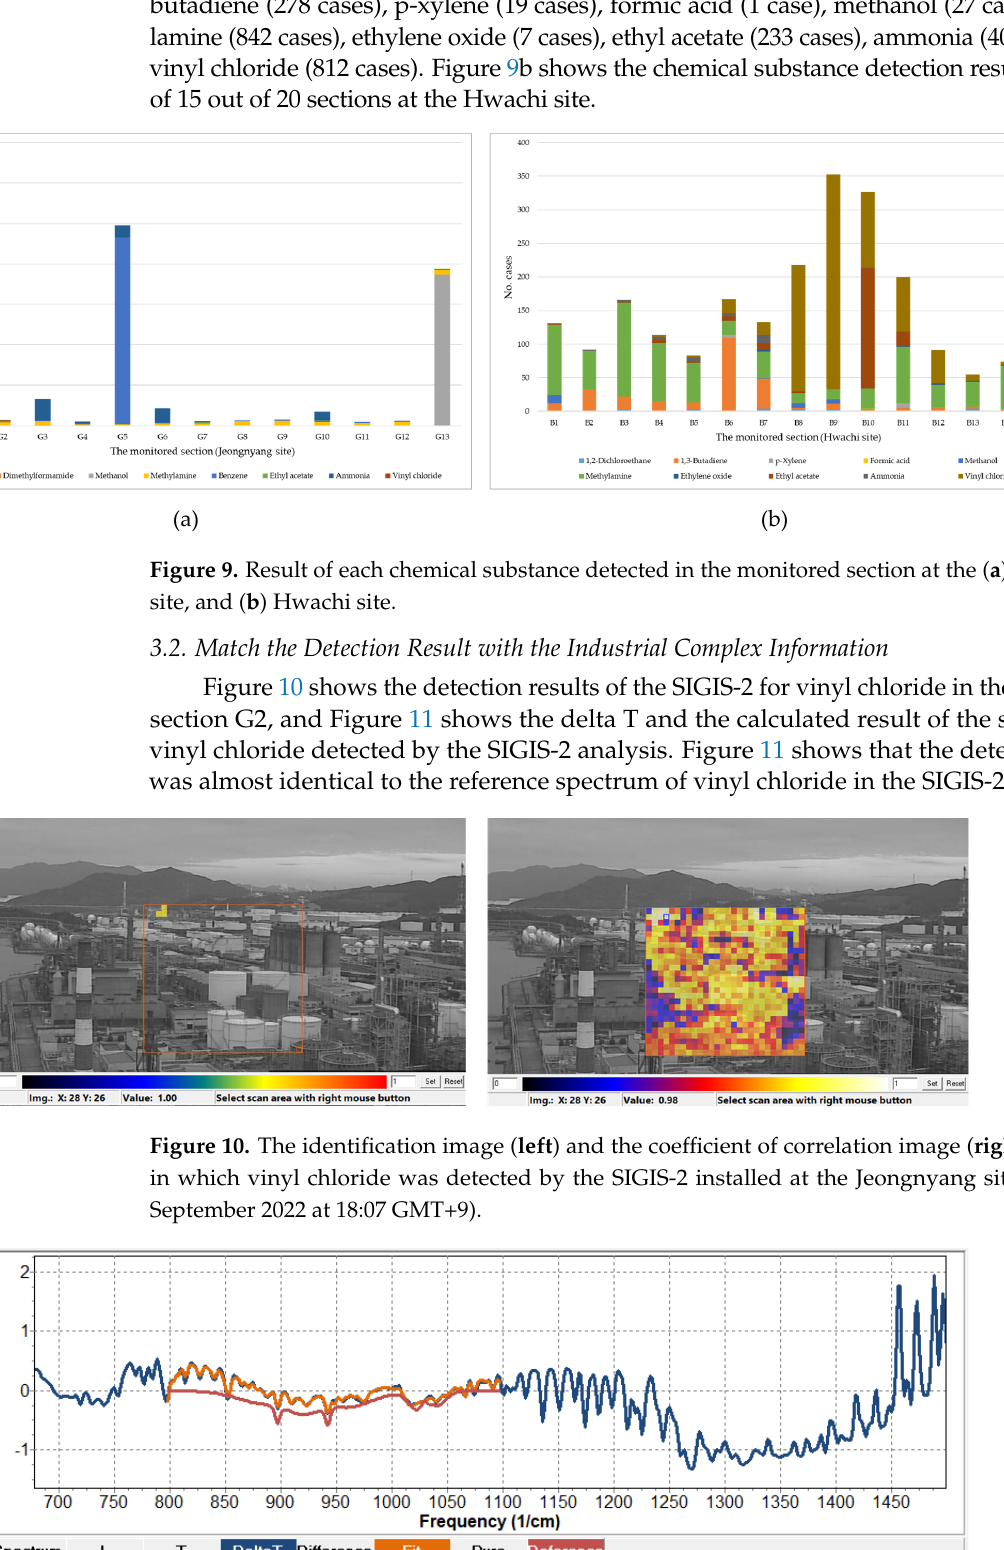
Figure 12. The actual handling information of vinyl chloride (orange dots) in monitoring section G2. (Source: Google earth). The overall results confirm that the industrial complex chemical accident monitoring system, based on a SIGIS-2 installed on a 70m-high steel tower, can detect chemical sub- stances from a distance. In Korea, when chemical accidents occur, any person who handles relevant chemicals can immediately (within 15 minutes) report the occurrence of such chemical accidents to the competent local government, local environmental agency, na- tional police agency, fire agency, or local employment and labor agency [29]. As such, chemical accident reports can be delayed depending on the speed of the people reporting, but this system can automatically alarm chemical accidents within 5 minutes after detect- ing chemical leakages, fires or smoke. Therefore, it is effective for early detection. The accumulated detection data shows that the detection frequency of a specific chemical sub- stance is high in each section. This can be used as a basis for modifying the threshold of the anomaly detection model. Additionally, it can identify chemical substances that are routinely emitted from workplaces, and based on this, the government can manage and supervise workplaces in industrial complexes.